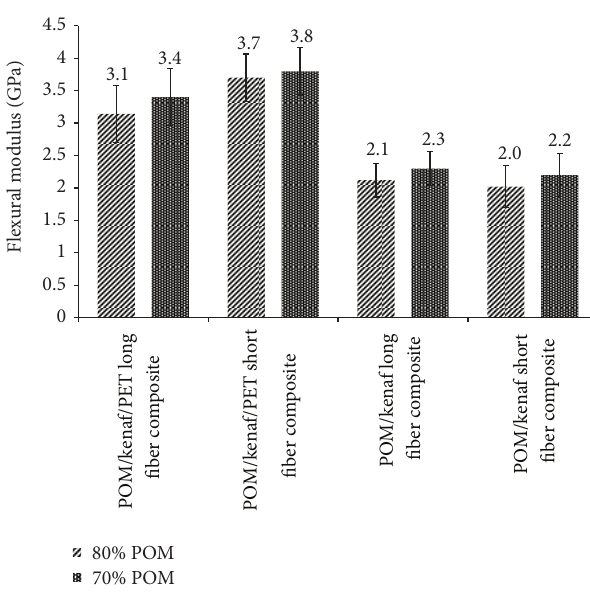
Figure 9: Flexural moduli of the controlled samples.